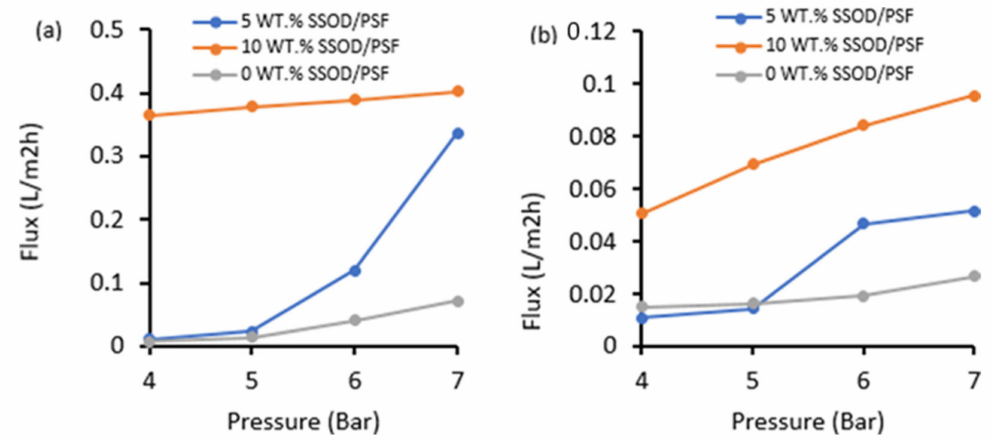
Figure 9. ( a ) Pure water flux ( b ) Phenol-containing water